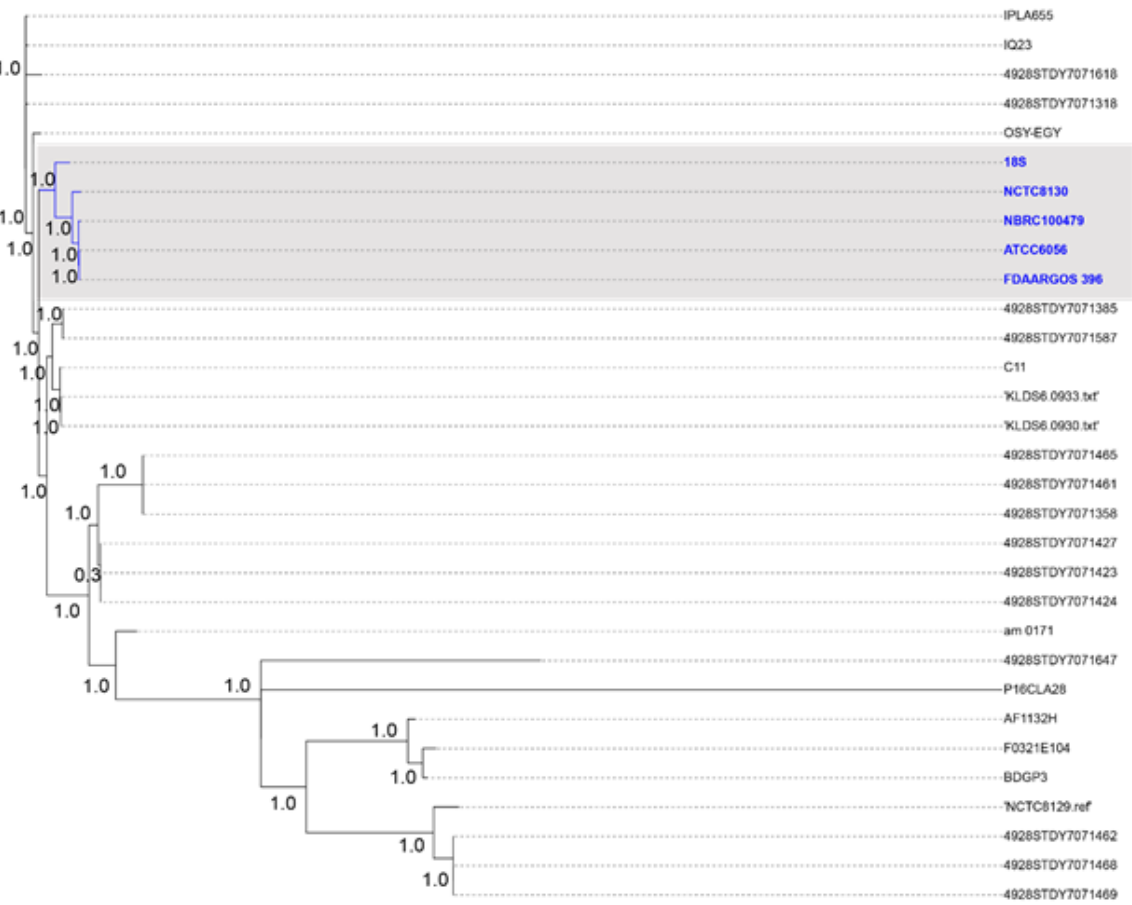
Figure 3 – Core genome SNP tree of 31 E. durans . The phylogenomic reconstruction was built using Parsnp and Fast tree 2. The percentage of the reference that is covered by core alignments was above 60%. Strains related with E. durans LAB18S are highlighted in the grey